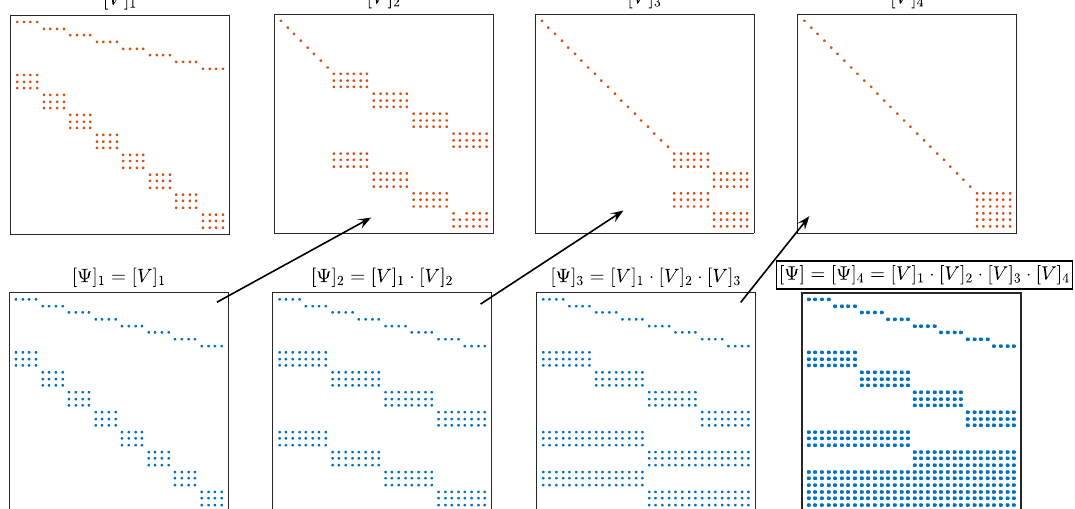
Fig. 1 Representations of the sparse Alpert wavelet matrices at different detail levels j . For each level j , the wavelet matrix ½ W (cid:7) cumulative product of the matrices ½ V (cid:7) computed for a one-dimensional mesh containing N ¼ 32 points